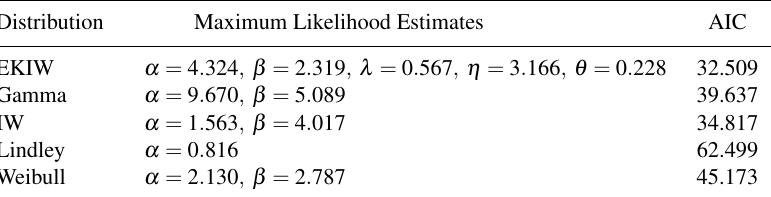
Table 3. The maximum likelihood estimates and AIC of the models based on data set.